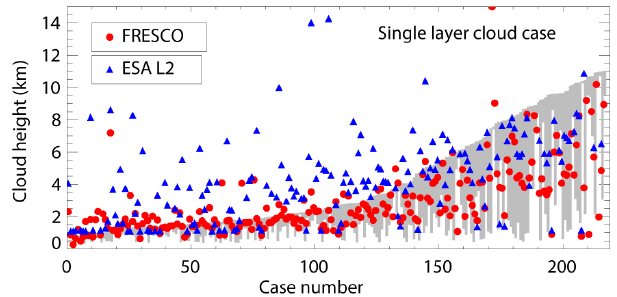
Figure 7. Comparison between SCIAMACHY ESA L2 cloud top height, FRESCO cloud height, and Cloudnet cloud top and cloud base height for single-layer clouds. The cases are sorted according to the Cloudnet cloud top height. The grey bar indicates the altitude range of the cloud according to the Cloudnet product. Here the cases with FRESCO effective cloud fraction below 0.1 are